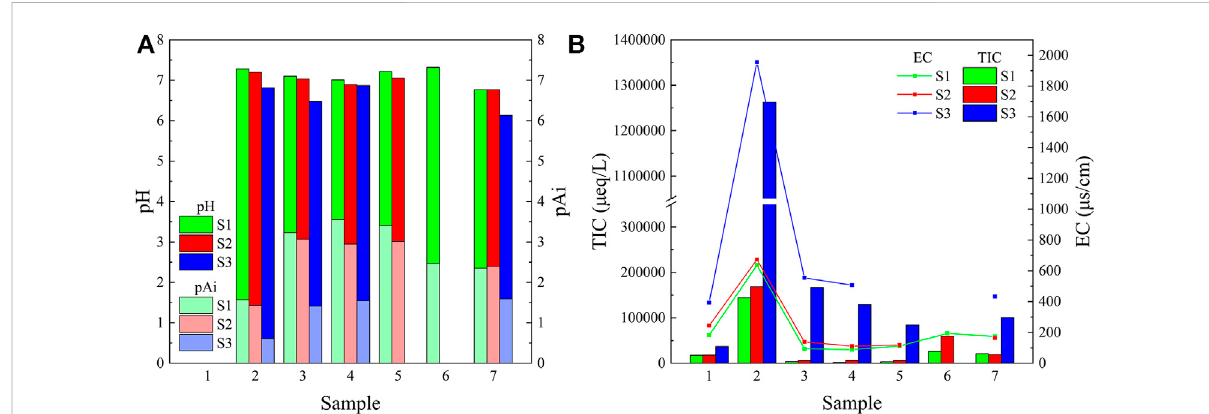
FIGURE 2 Thevaluesof (A) pH,pAi, (B) electricalconductivity(EC),andtotalionconcentration(TIC)inthethree-stagefogwatermeasuredinDonghaisite. The S1, S2, and S3 represent the sample for the large droplets of diameter larger than 22 μ m, medium droplets of diameter within 16 – 22 μ m, and small droplets of diameter within 4 – 16 μ m, respectively.